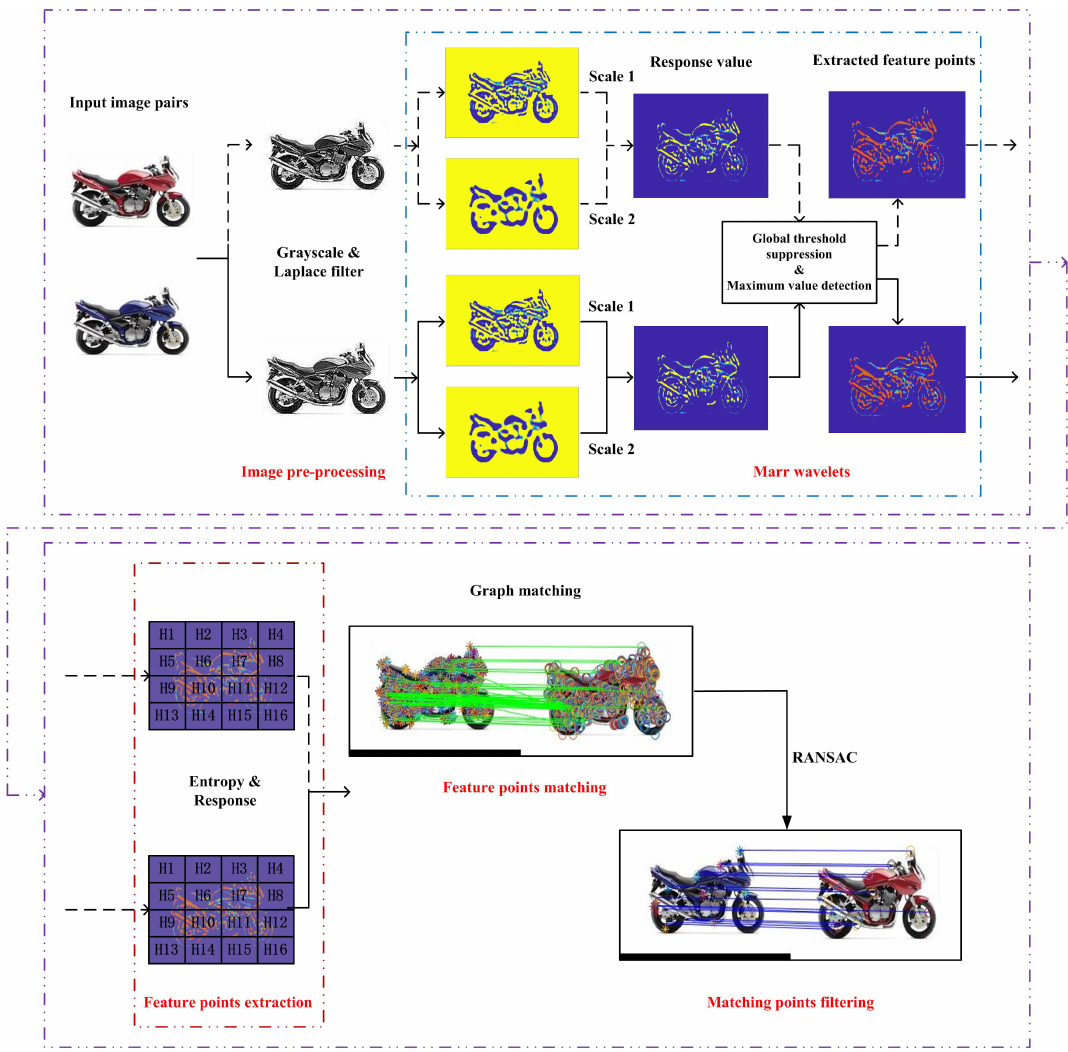
Figure 2. The basic flowchart of graph